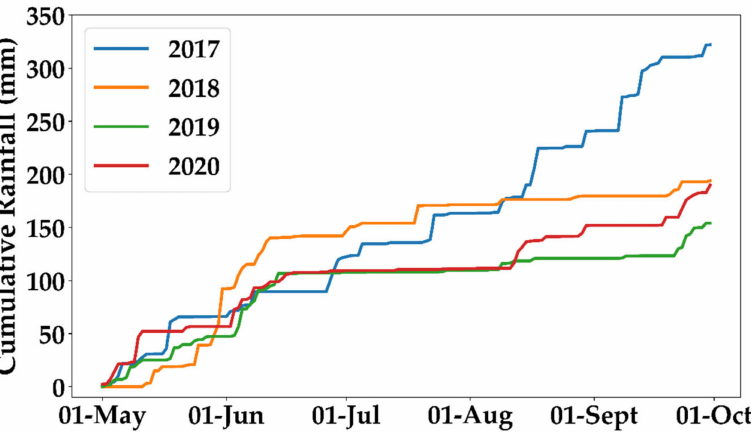
Figure 9. Daily cumulative rainfall for the period between May and October for 2020 (red), 2019 (green), 2018 (orange), and 2017 (blue) over the study